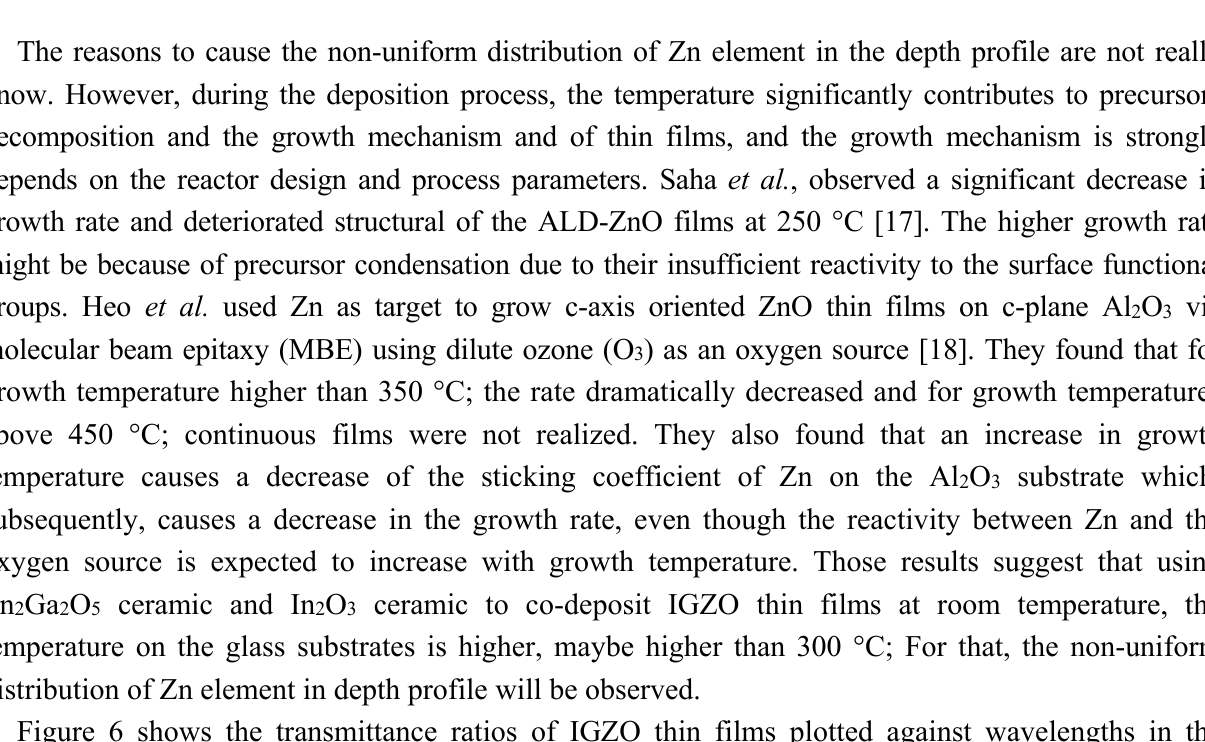
Figure 5. Second ion mass spectrometry analysis of IGZO thin film, the deposition power of GZO ceramic target was ( a ) 80 W ( b ) 100 W and ( c ) 120